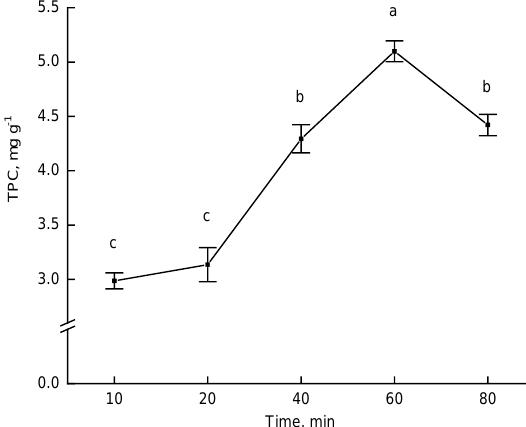
Figure A4. Effect of extraction time on the extraction of phenolic compounds from apple pomace (C(Tween 80) 1%, solid-to-material ratio 80 mL g −1 , pH 4). Different lower case letters indicate significant differences among treatments ( p ≤ 0.05) based on post hoc Tukey’s test.